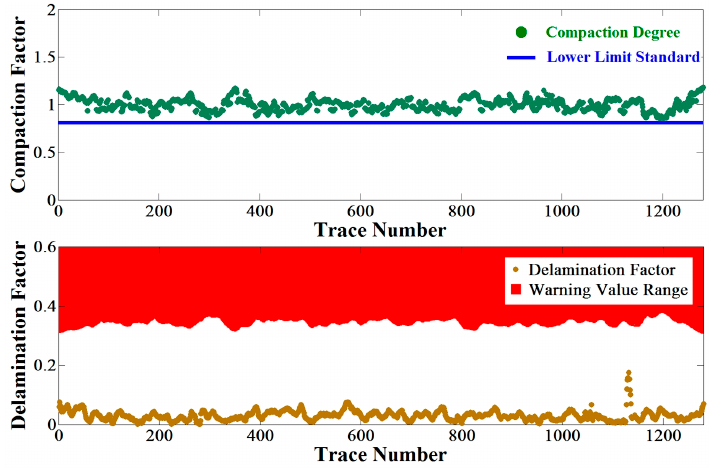
Figure 15. The compaction factors and delamination factors of STR19.